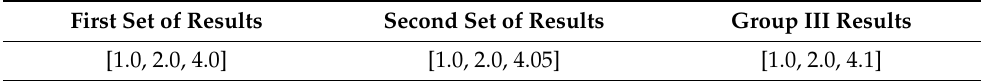
Table 2. The second measured results of the algorithm.